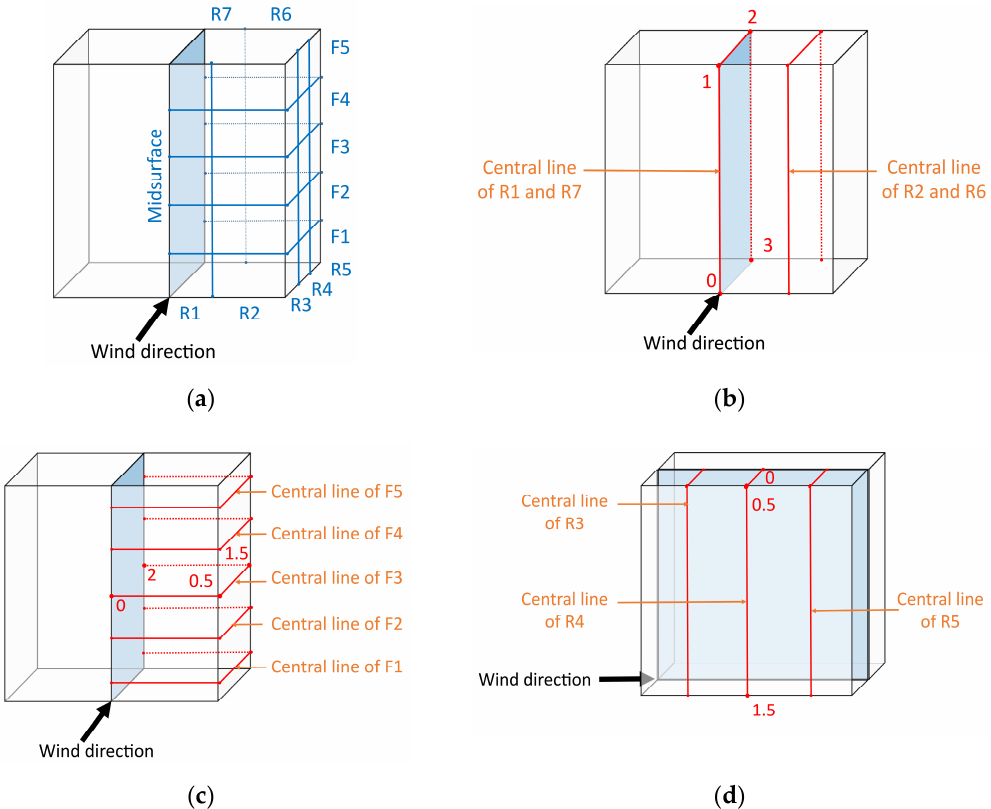
Figure 11. Arrangement of rooms and measurement lines. ( a ) Locations of seven rows and five floors, ( b ) W-R-L lines along windward, roof and leeward surfaces; ( c ) W-S-L lines along windward, lateral and leeward surfaces; and ( d ) R-S lines along roof and lateral surfaces.